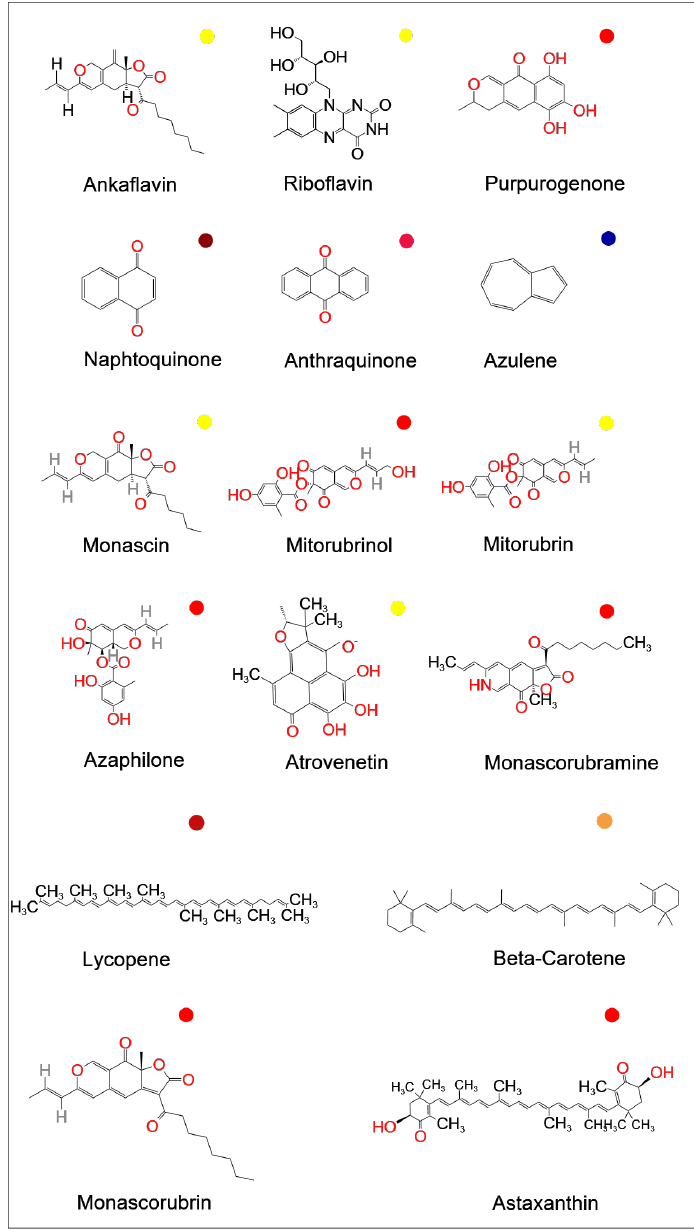
Figure 4. Chemical structure of some available fungal food pigments (Source: National Center for Biotechnology Information. PubChem Compound Database; (https://pubchem.ncbi.nlm.nih.gov); accessed on 1 April 2023).